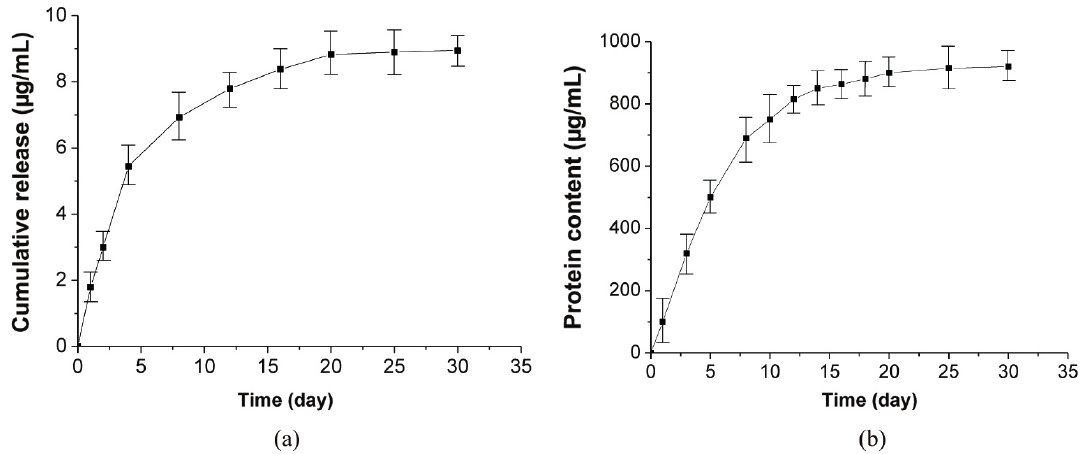
Figure 2. (a) In vitro release profile of steroidal saponins from microspheres suspended in phosphate-buffered saline under gentle agitation over 35 days. (b) In vitro degradation rate of collagen microspheres in phosphate-buffered saline. Each data point is the mean±standard deviation of five separate aliquots of microspheres in suspension. Table 1. Steroidal saponin concentration in collagen microspheres conditioned media. Media collection interval